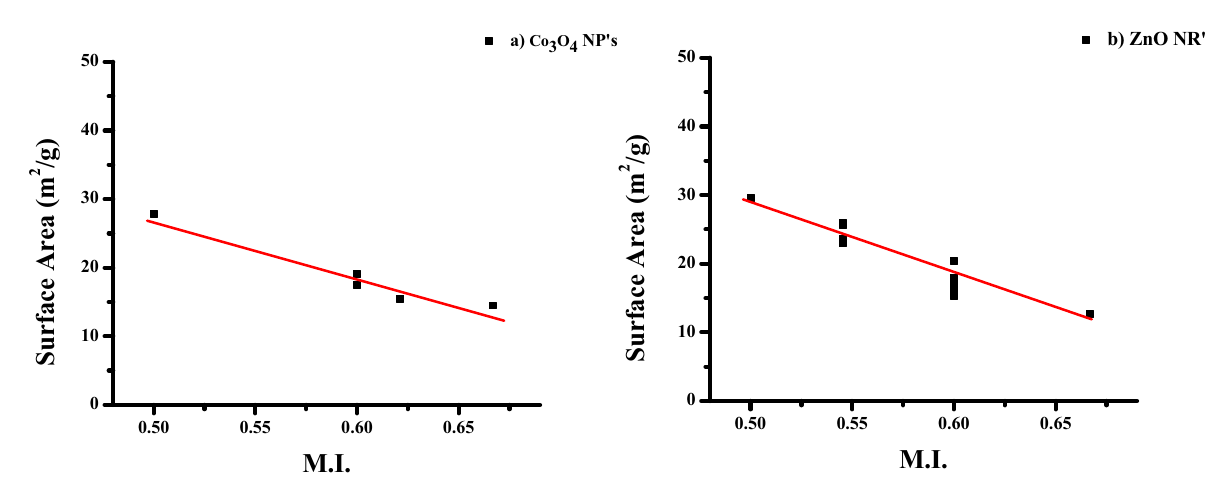
Figure 4. Morphological Index versus specific surface area of ( a ) Co 3 O 4 NPs and ( b ) ZnO